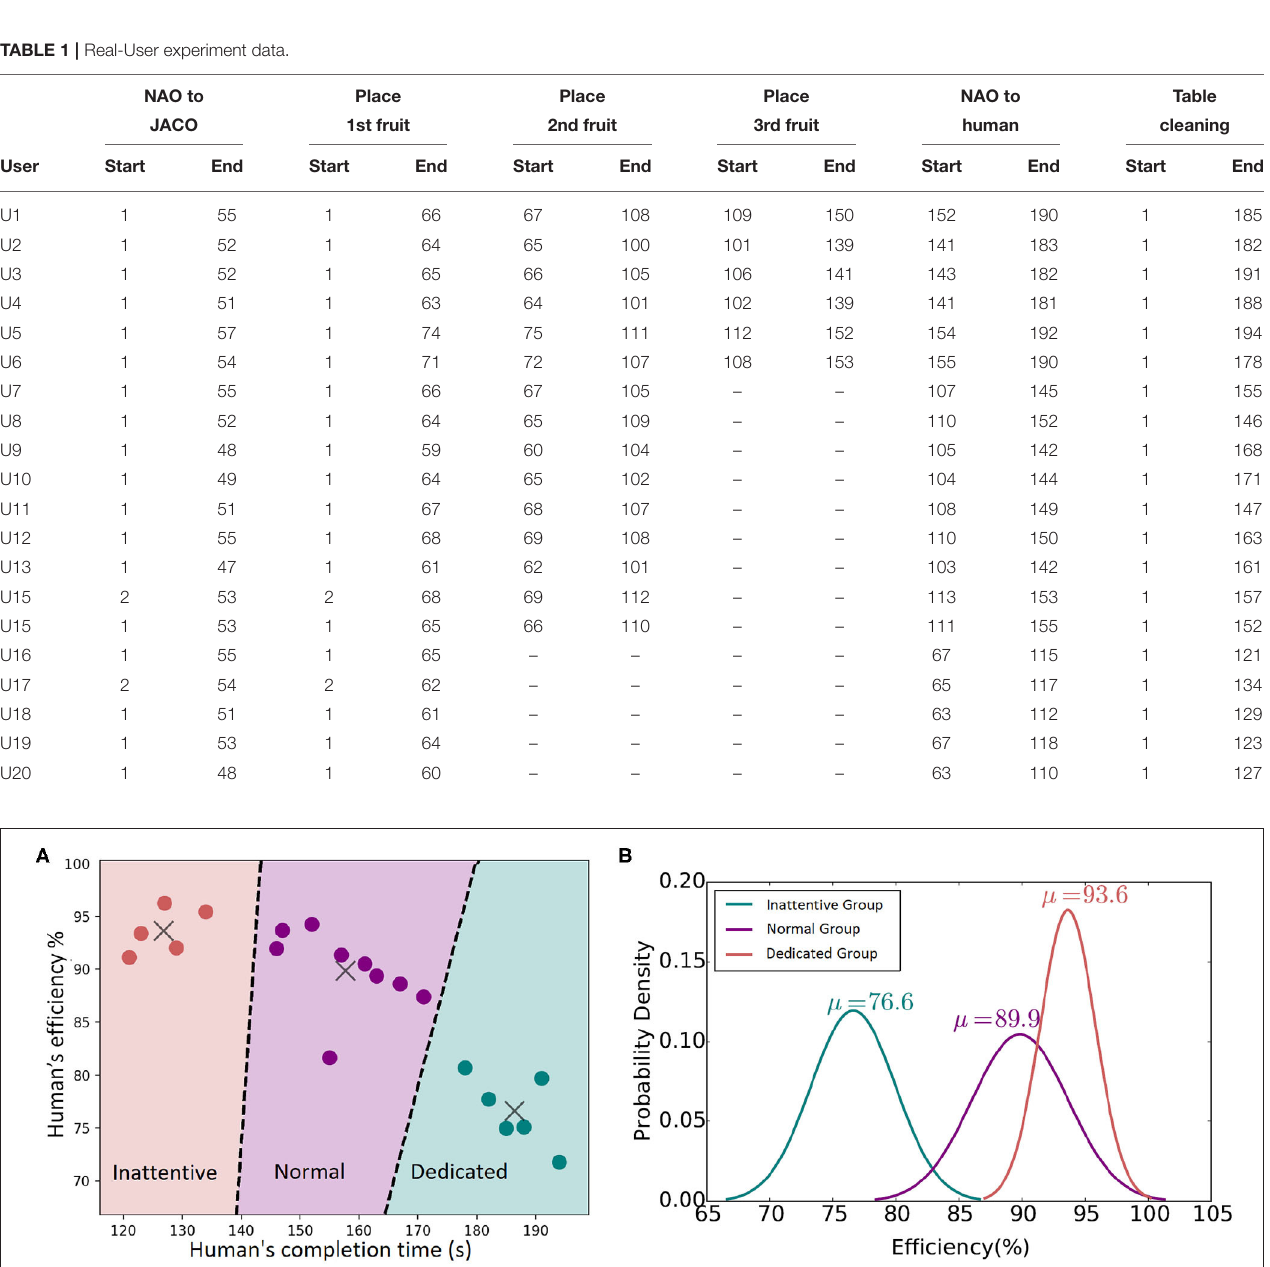
FIGURE 6 | (A) Human’s behavior classification. (B) Normal distributions of each group’s